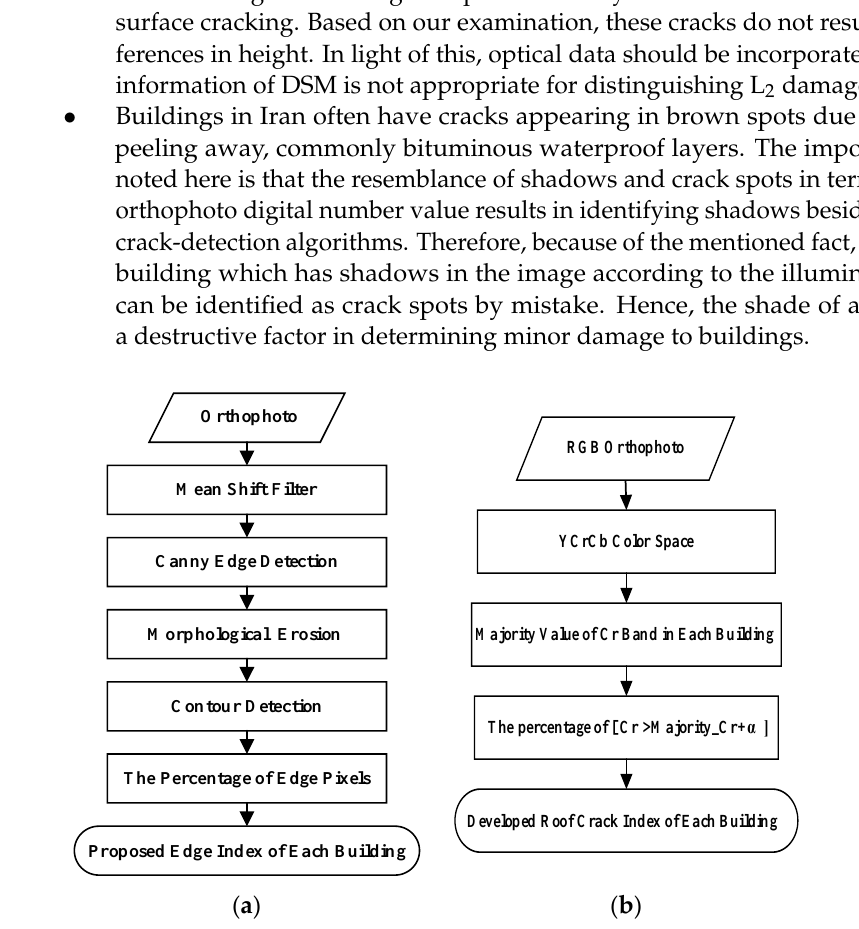
Figure 4. ( a ) The flowchart of the presented edge index, ( b ) the flowchart of the developed roof crack index.